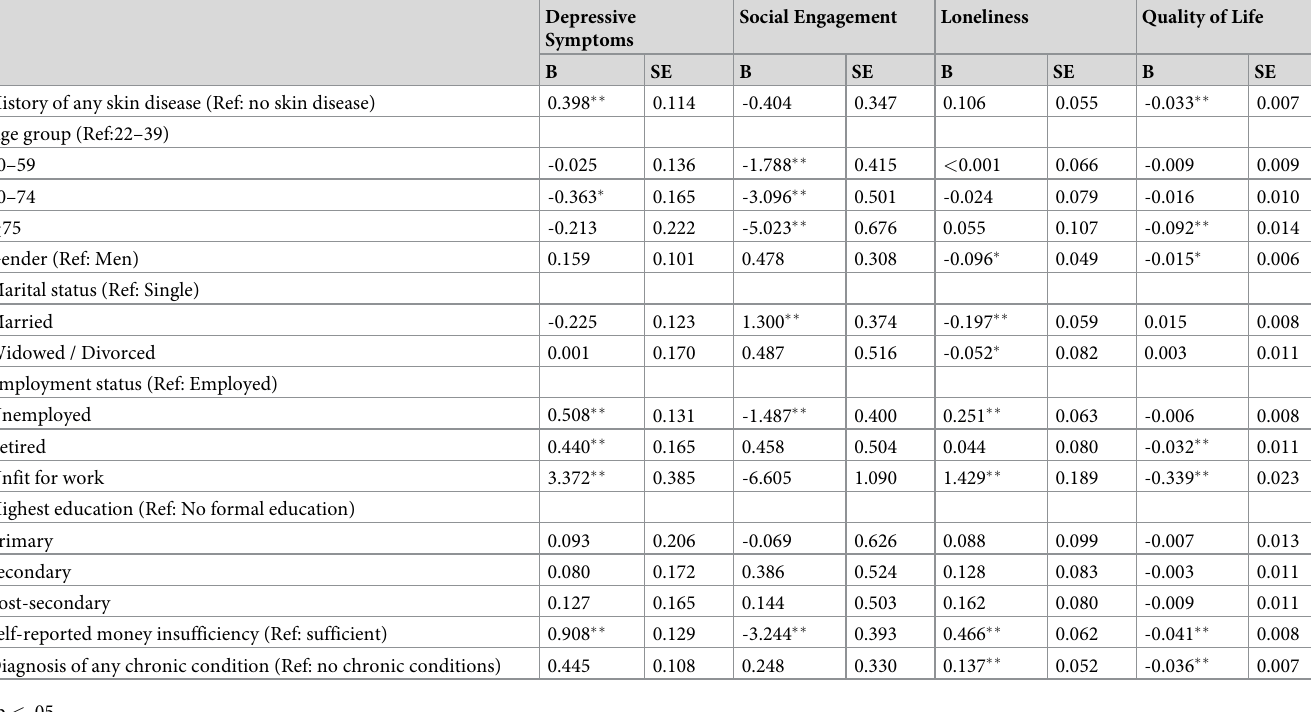
Table 5. Associations between history of any listed skin disease and psychological, social wellbeing and quality of life using multiple linear